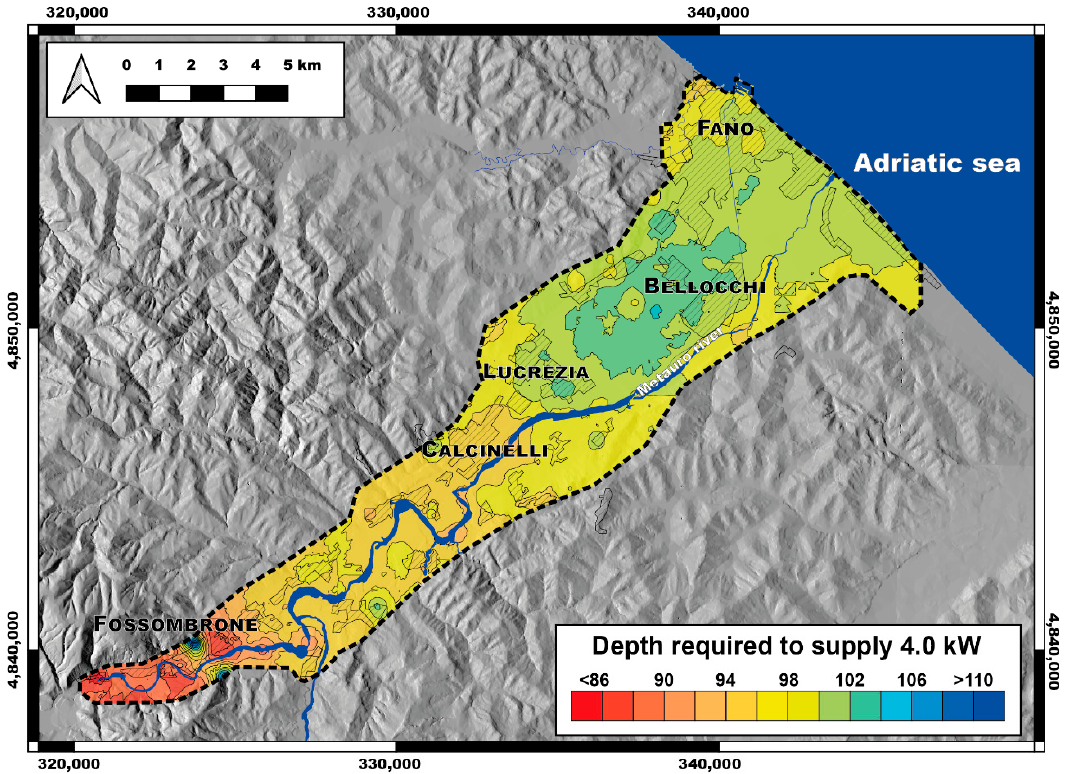
Figure 9. Map of the estimated depth to be drilled for supply a fixed domestic energy demand of 4.0 kW.